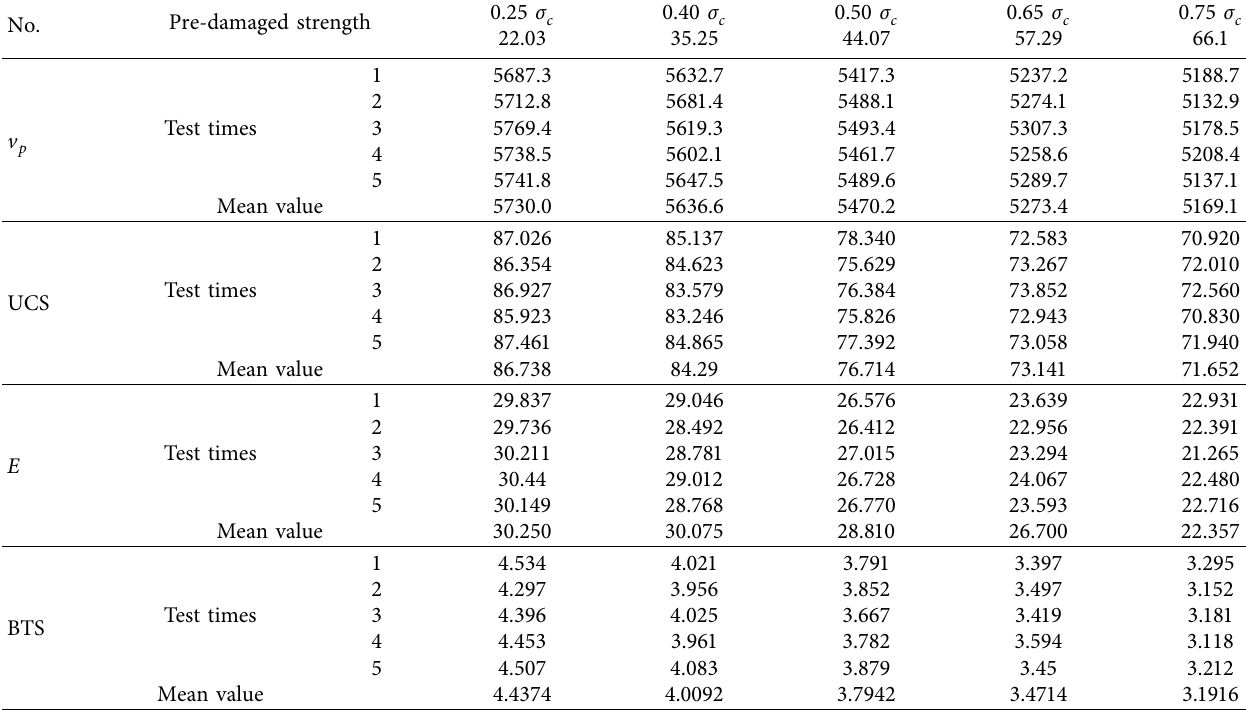
Table 2: Physical and mechanical parameters of pre-damaged specimens.